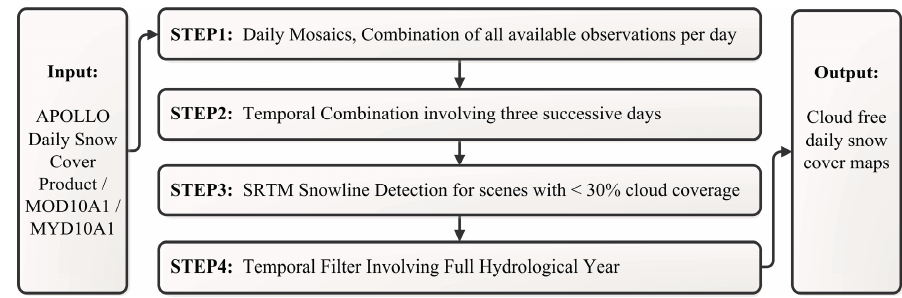
Figure 5. Cloud interpolation steps applied to the time series of daily snow cover